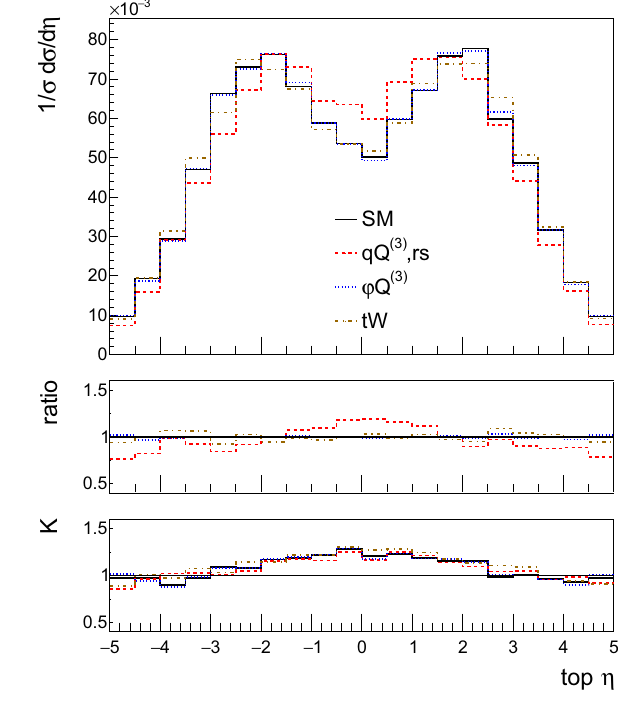
Fig. 3 The NLO distributions of the stable top quark transverse momentum and rapidity for the SM and the three effective operators of interest Eqs. (1.2–1.4) for the couplings values of Table 2. The ratio